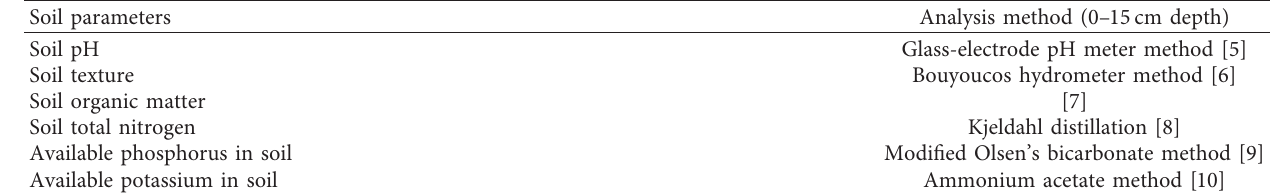
Table 2: Soil analysis